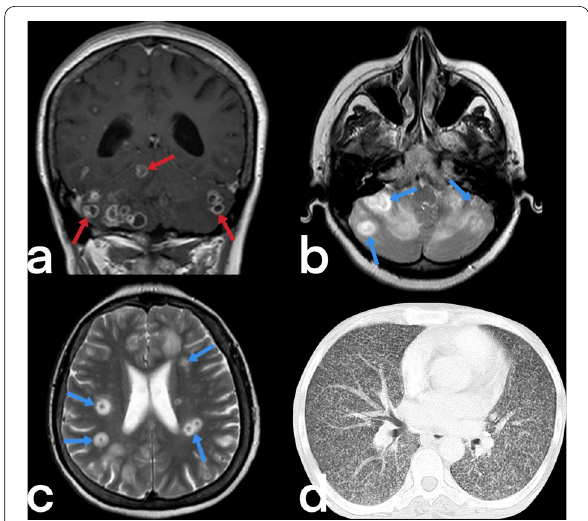
Fig. 3 Radiologic images of a 38-year-old-female who has a diagnosis of miliary TB. Multiple tuberculomas (red arrows) show peripheral rim-like enhancement on post-contrast T1 weighted image in the cerebellum ( a ). On T2-weighted images ( b, c ) demonstrate focal lesions (tuberculomas) with central isointense signal and peripheral hyperintensity in gray matter (blue arrows). Multiple nodules secondary to miliary TB are seen ( d )